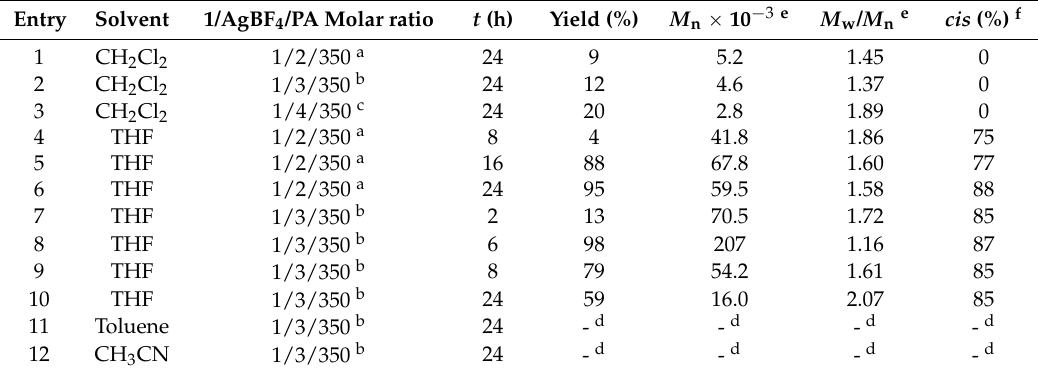
Table 2. Polymerization of phenylacetylene (PA) with the catalytic system 1 /AgBF 4 .